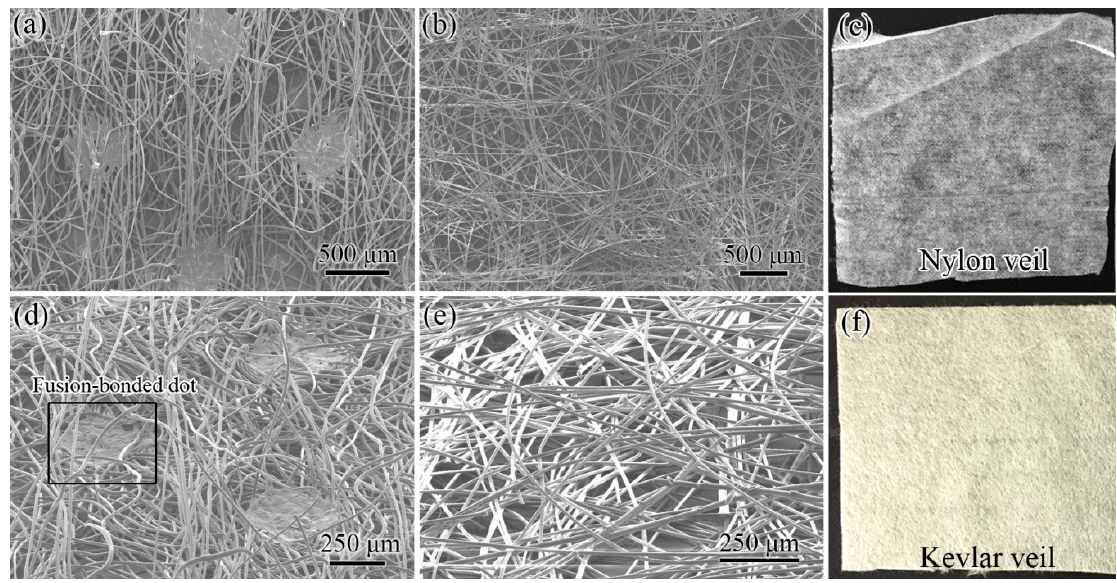
Figure 2. SEM images of the interleaves: ( a ) NV, ( b ) KV, ( d ) NV, 45° tilted, ( e ) KV, 45° tilted, and optical images of the ( c ) NV and ( f ) KV.